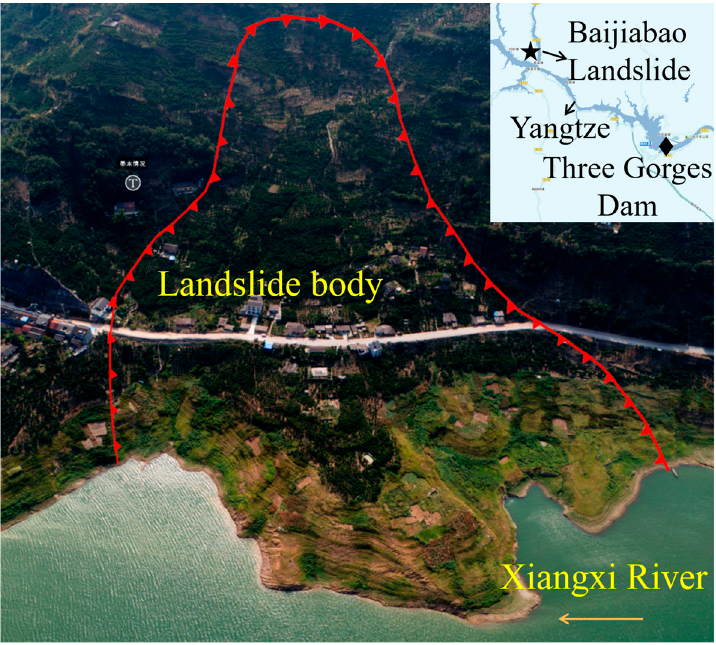
Figure 11. Baijiabao landslide.